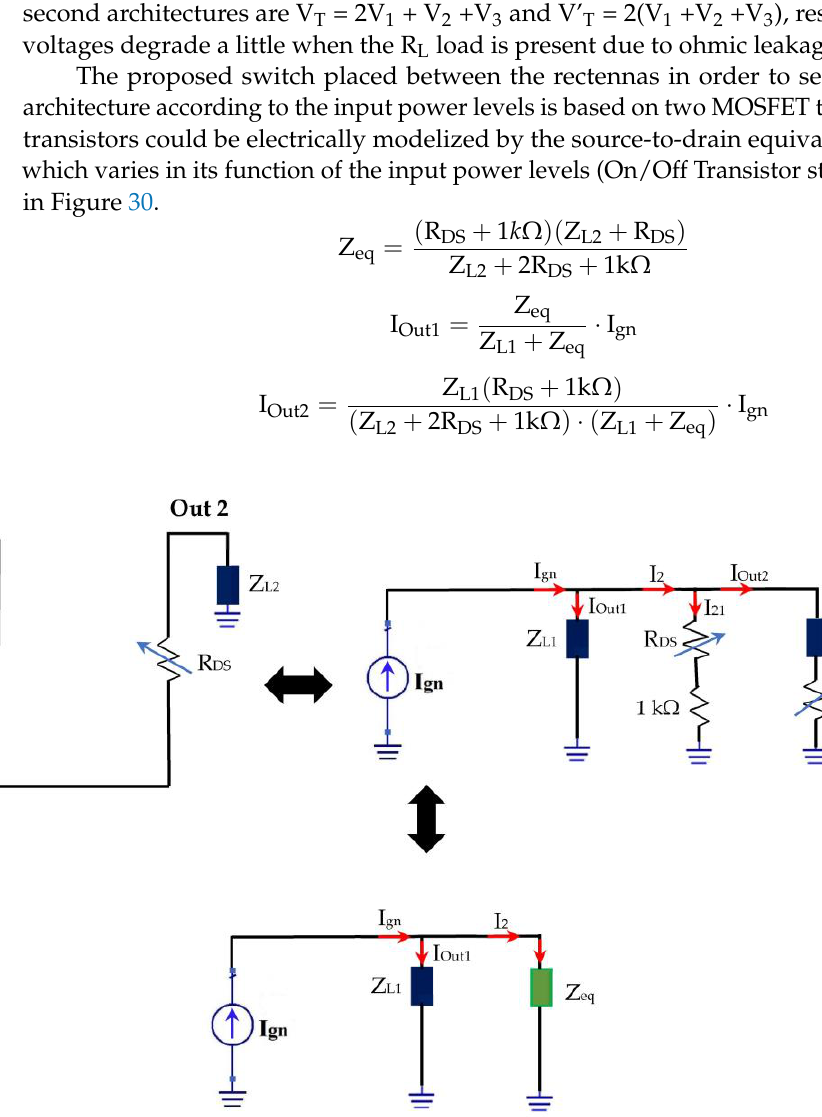
Table 7. Comparison between proposed RF-EH system performances and other systems reported in the literature.